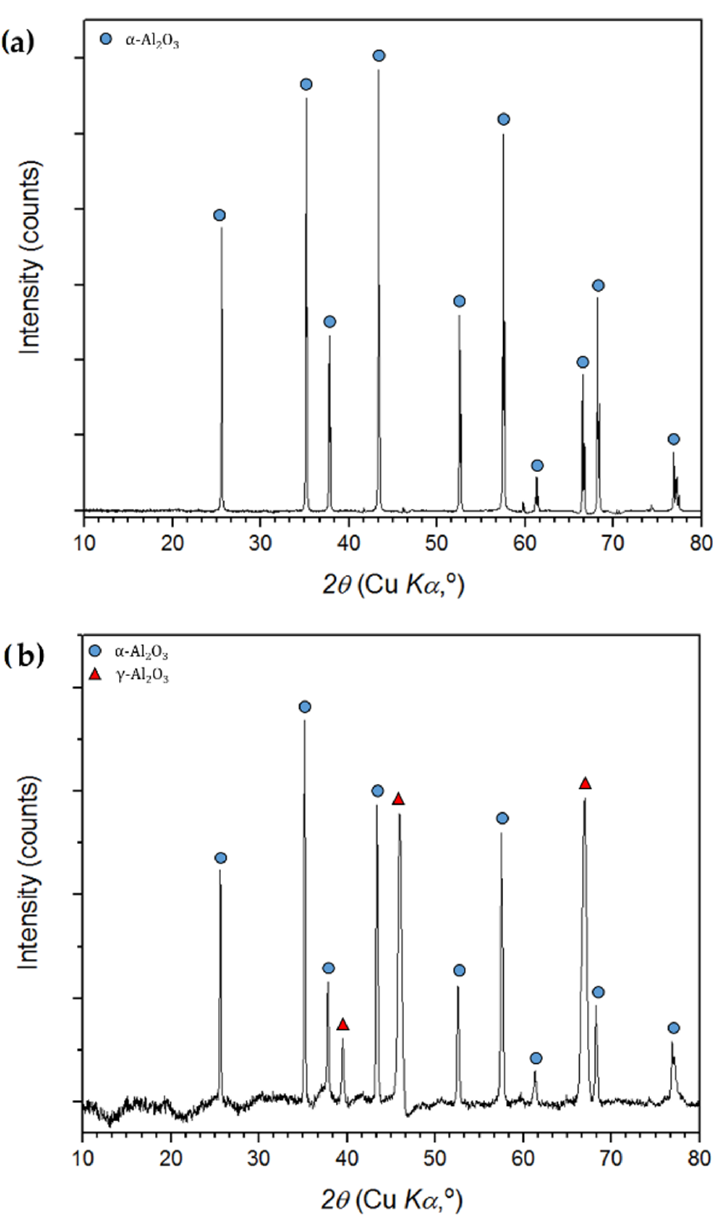
Figure 4. XRD diffractograms of ( a ) the Metco 6103 feedstock and ( b ) the manufactured coating (S- HVOF).